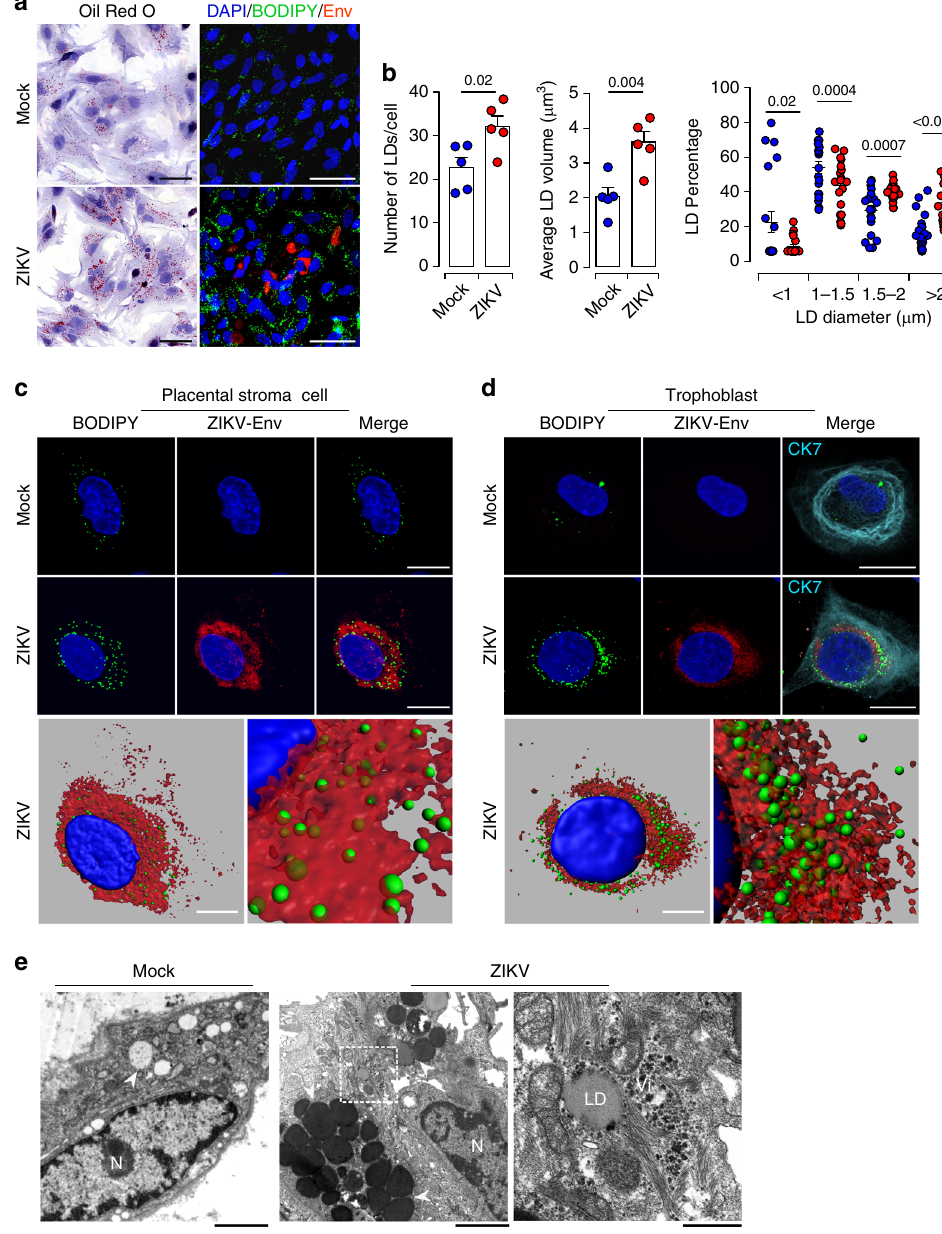
Fig. 4 Alterations of LD morphometric features by ZIKV infection of primary placental cells. Matched freshly isolated placental cells are mock- or infected with ZIKV at MOI of 1 for 5 days. a Oil Red O staining (Left panel). Co-immunostaining of LDs with the BODIPY 493/503 dye (green), anti- Flavivirus group antigen antibodies (Env, red), and nuclei (DAPI in blue) (Right panel). Scale bar 50 μ m. b Quanti fi cation of LD number per cell, average volume and diameter distribution by Imaris software. LD morphometric features are analyzed in more than 400 cells for each placenta from fi ve independent donors. P values are computed using two-tailed Student ’ s t test. c – d Representative confocal images with high magni fi cation of Z-stack projections. stromal cell ( c ), CK7 positive trophoblast cell ( d ). BODIPY 493/503 (green), Env (red), cytokeratin 7 (CK7 in cyan) and nuclei (DAPI in blue). Scale bar, 20 μ m. Bottom panels showing 3D models and higher magni fi cation focus on ZIKV-infected placenta stromal cell ( c ) and trophoblast cell ( d ). Scale bar, 10 μ m. e Representative TEM micrographs showing LDs in ( a ) mock- and ( b ) ZIKV-infected placental cells (white arrowheads), nucleus (N). Scale bar, 2 μ m. c High magni fi cation of the white square delineated area in ( b ) with a concentration of LDs around a large amount of viral particles (Vi). Scale bar, 500 nm. Data are representative of at least three independent experiments. Source data are provided as a Source Data fi